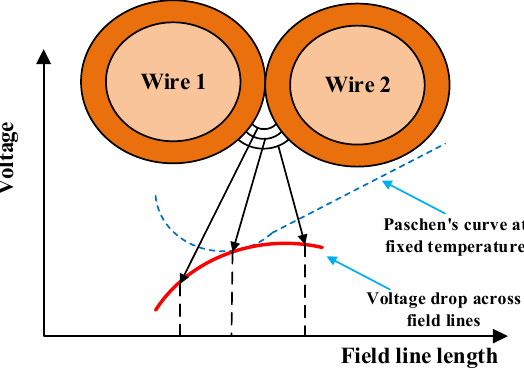
Figure 10. Computation of the inter-turn PDIV through Paschen’s law.